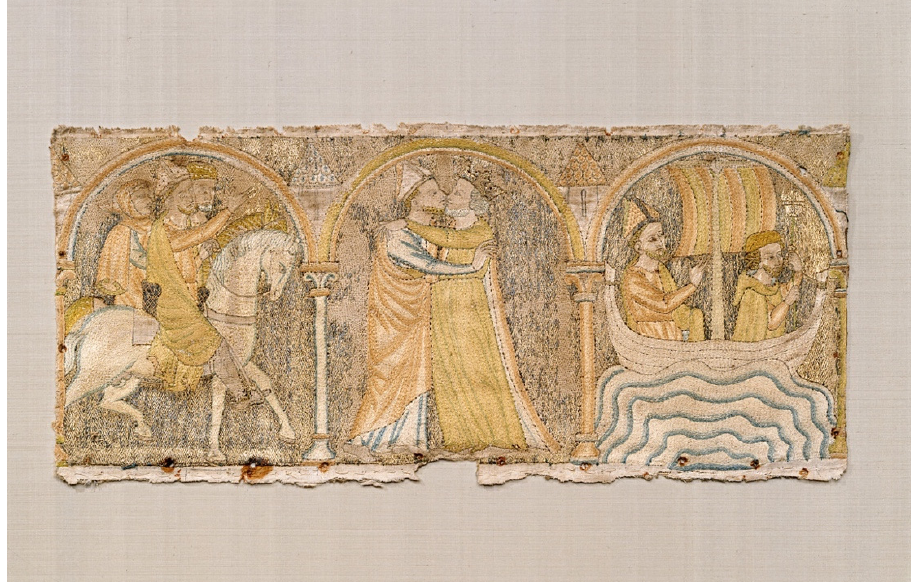
Figure 10. Second embroidered panel, Thomas Becket’s hagiographic cycle, second half of the thirteenth Century. Abegg-Stiftung Foundation, Switzerland. © Abegg-Stiftung, CH-3132 Riggisberg, 2008. Photo: Christoph von Viràg.